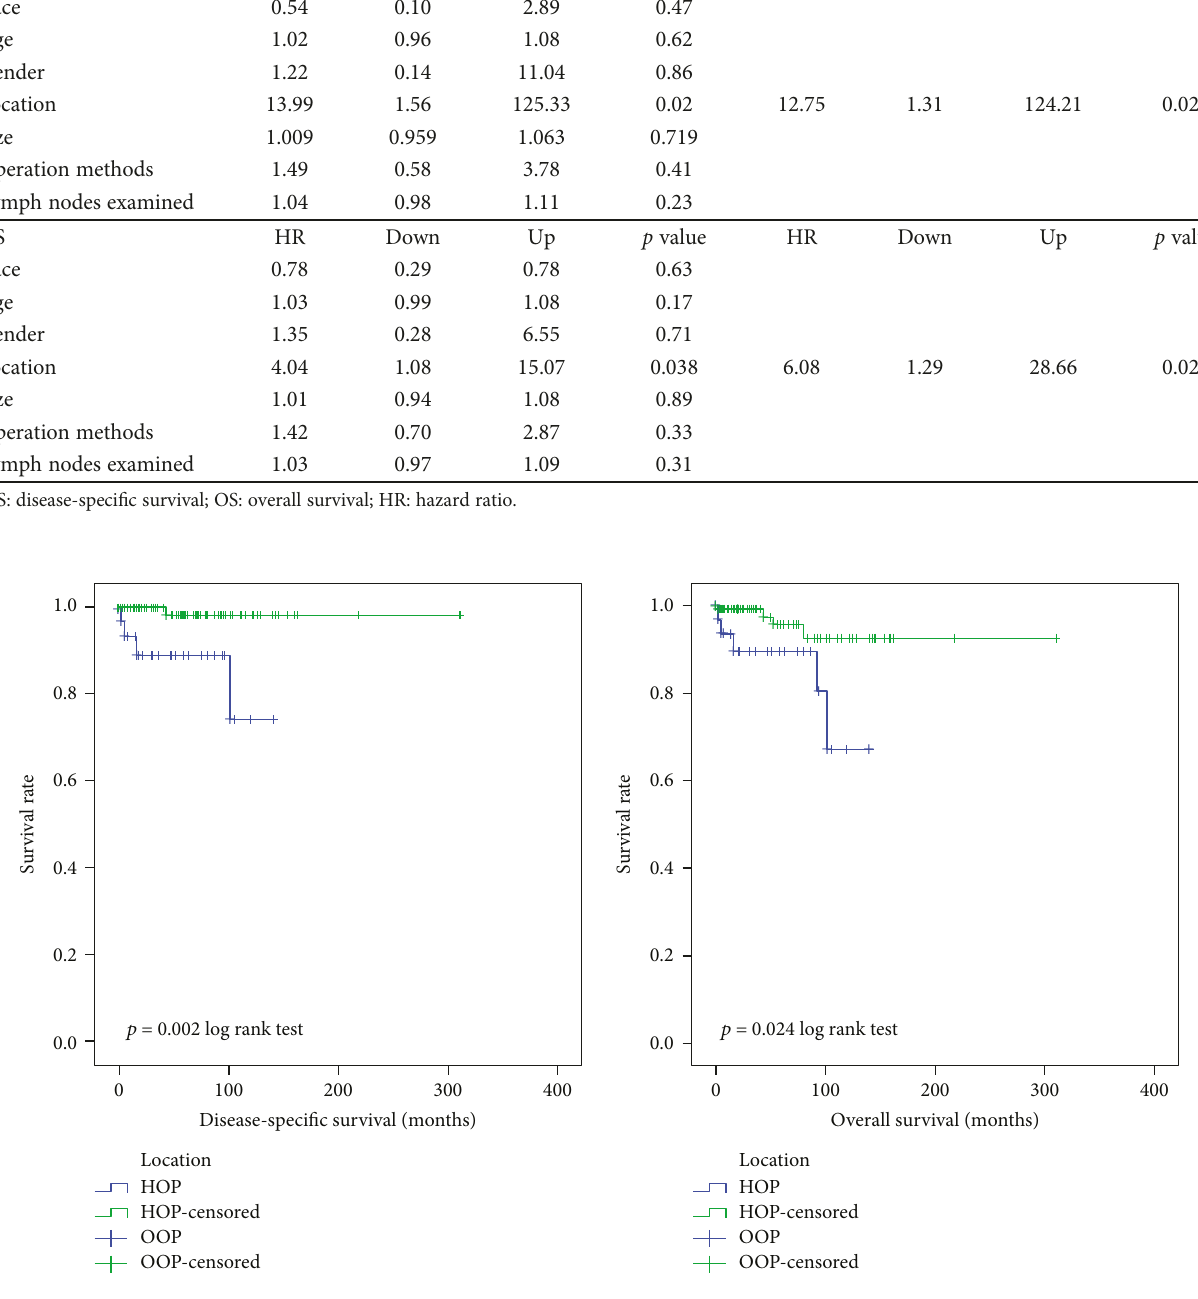
Operation methods